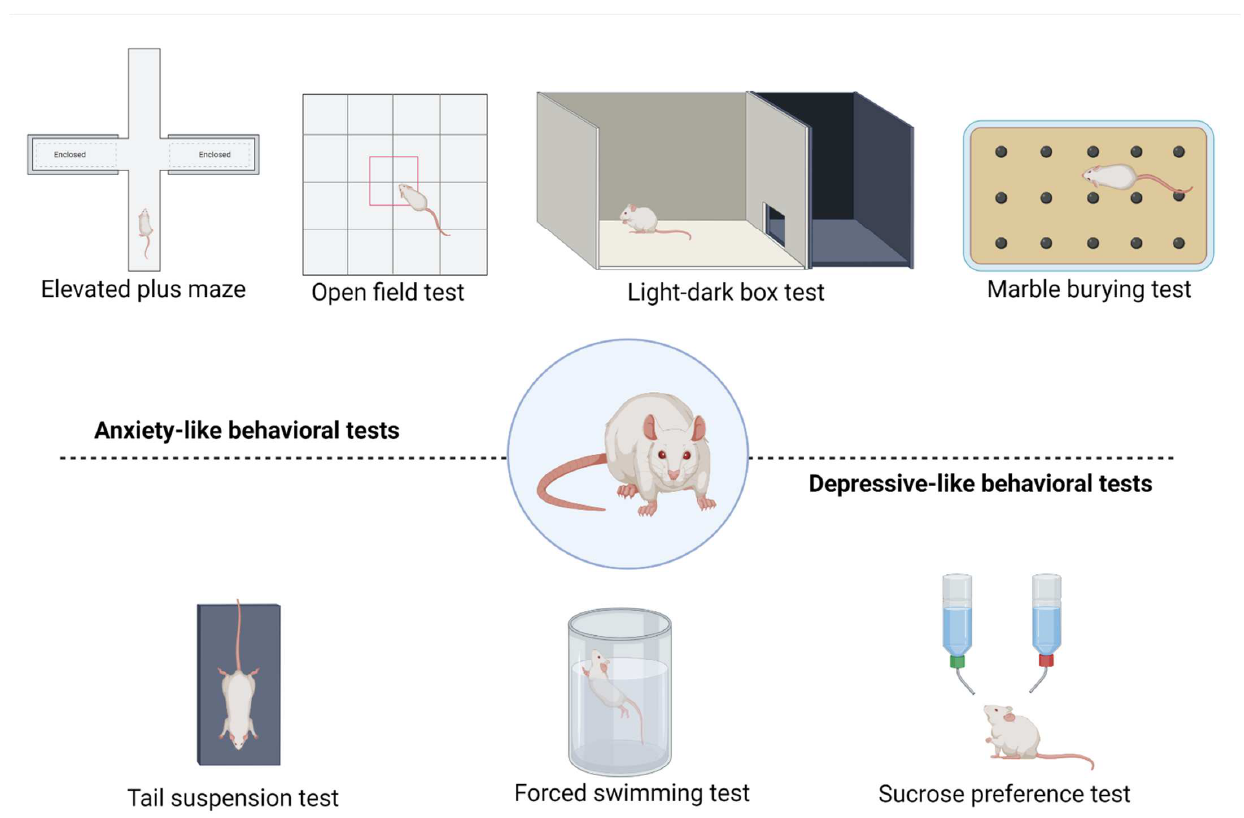
Figure 2. Behavioral tests used to study sex differences in anxiety-like and depressive-like behaviors in rodent animal models. Created with BioRender.com (accessed on: 15 February 2022). Elevated plus maze test (EPM) : The most extensively used test to analyze anxiety states exploits the natural aversion of rodents to open, elevated, and illuminated spaces. The maze consists of two walled arms opposite to two open arms, raised at around 50 cm from the floor. Time (usually expressed in percentage) spent in, and number of entries to, open arms is indicative of less anxiety-like behavior [31]. Compelling evidence indicates that males present less anxiety-like behavior assessed in the EPM than females. However, some studies showed that females made more open arms entries [32,33] and spent more time on the open arms of the EPM than males in unmanipulated [32,34], stressed [35], or drug-treated [36] animals. While some studies suggest a lack of estrous cycle effect [37], at least some of the sex differences observed in EPM may be attributed to activation by circulating gonadal hormones [38,39] (see below). The Elevated Zero Maze (EZM) is a circular variant of the EPM in which the disposition of open and enclosed quadrants avoids the central zone of the EPM. Some authors argue that this apparatus is better for assessing anxiety-like behaviors [40], particularly because it shows more consistent be-